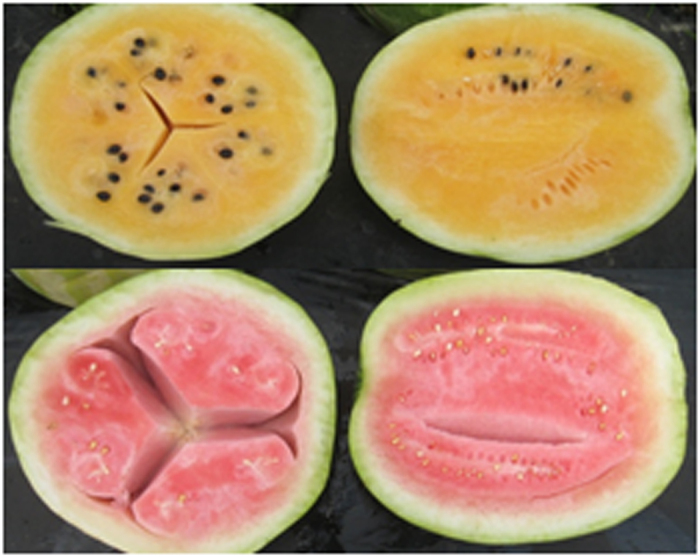
Hollowheart defect in watermelon.